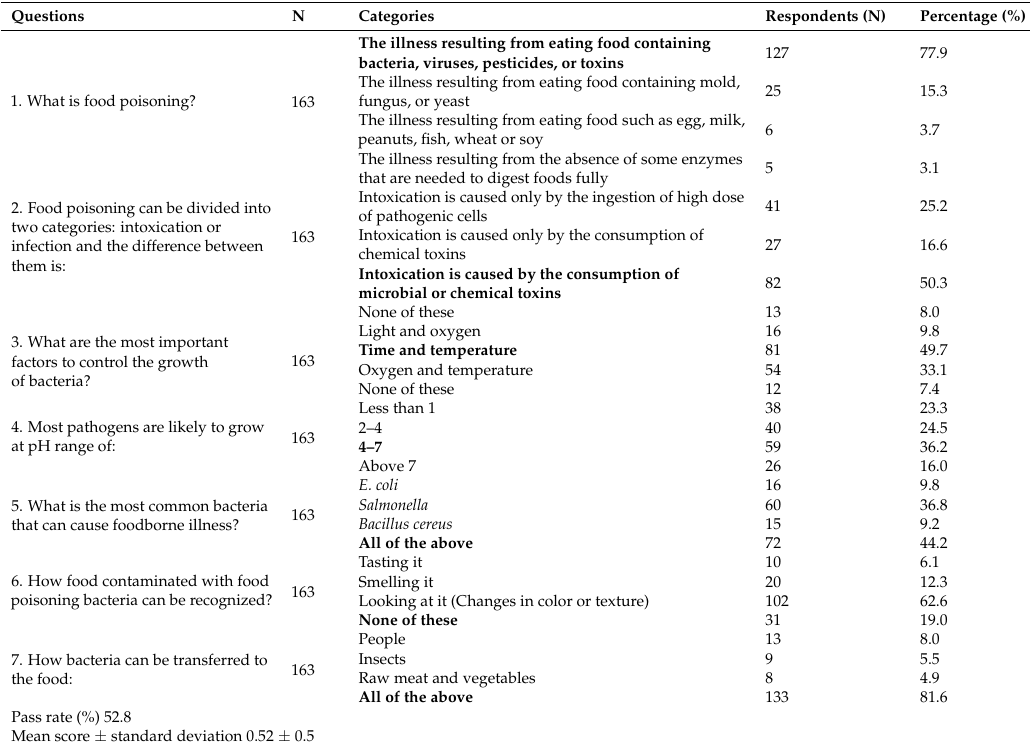
The correct answers are highlighted in bold in the